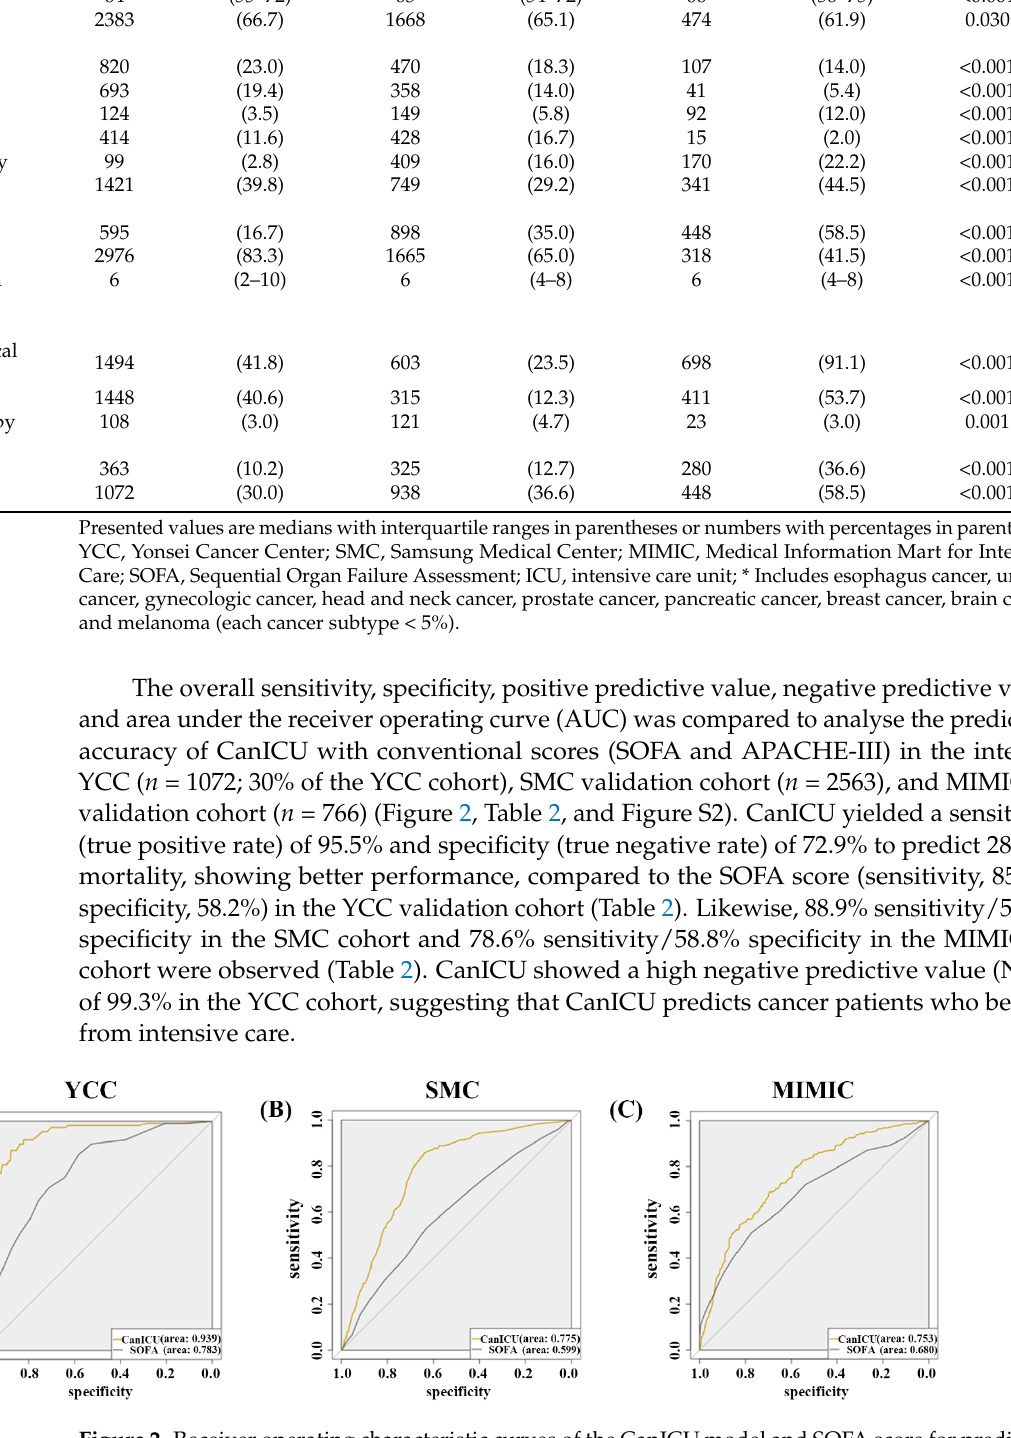
Figure 2. Receiver operating characteristic curves of the CanICU model and SOFA score for predicting 28-day mortality and one-year mortality: ( A ) YCC model for 28-day mortality. ( B ) SMC model for 28-day mortality. ( C ) MIMIC-III model for 28-day mortality. YCC, Yonsei Cancer Center; SMC, Samsung Medical Center; MIMIC, Medical Information Mart for intensive